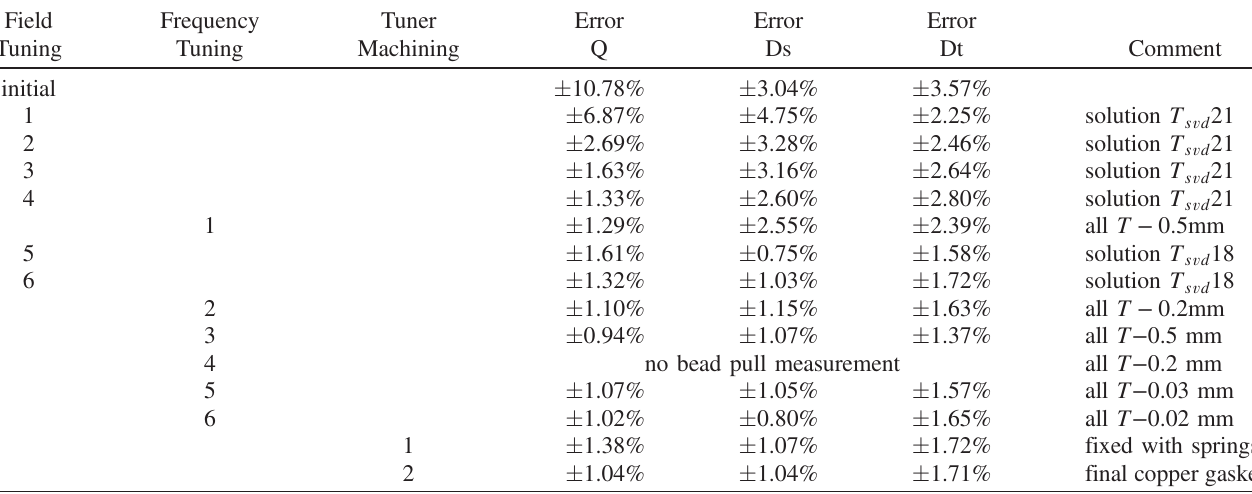
TABLE III. Field and frequency tuning steps and tuner cutting in chronologic order.